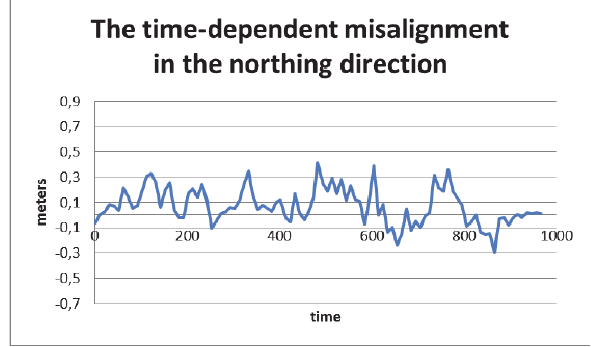
Figure 7. The misalignment of the BLS patch centre points in the northing direction.